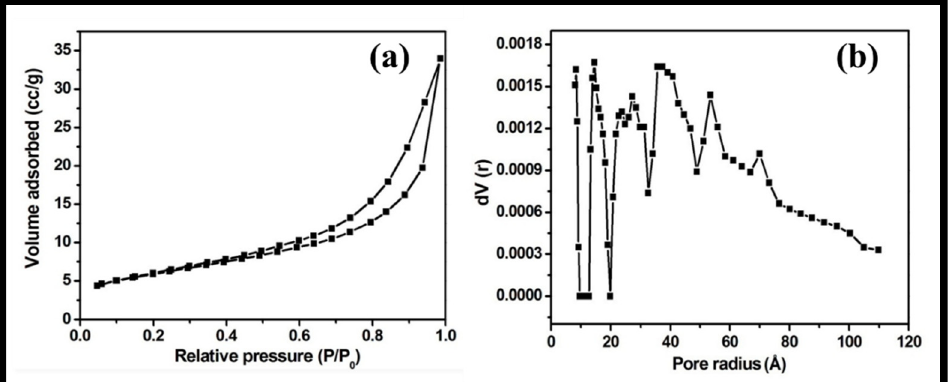
Figure 6. Typical ( a ) nitrogen adsorption–desorption isotherm and ( b ) DFT pore size distribution of the synthesized rGO-WO 3 heterostructure.